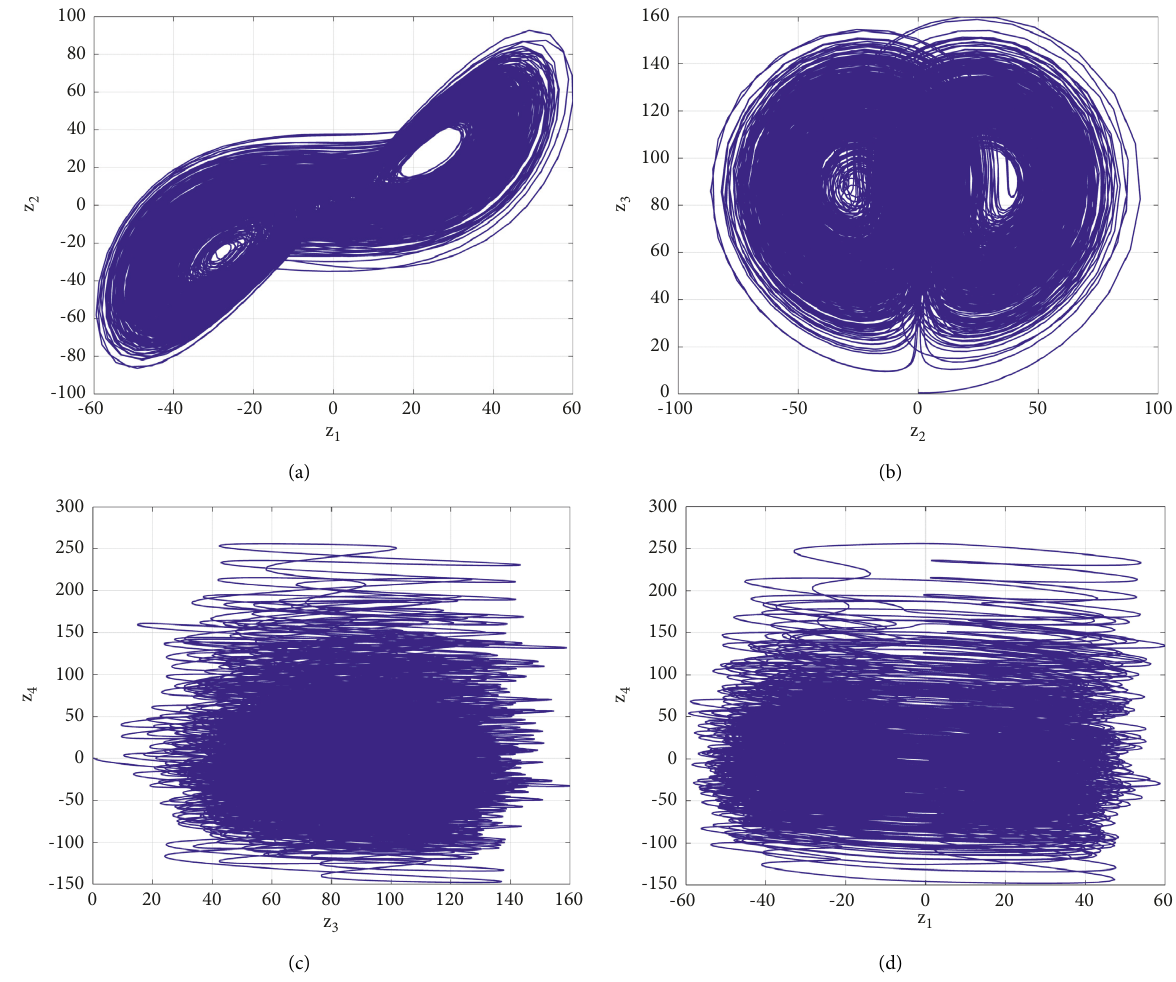
Figure 1: Various MATLAB signal portraits of the 4-D hyperchaotic two-scroll dynamics